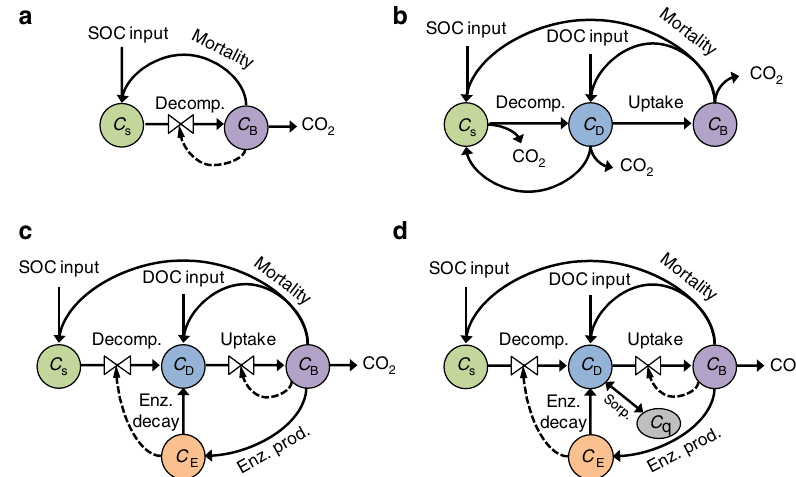
Fig. 1 SOC decomposition models compared in this study. a Two-pool microbial model with SOC ( C S ) and microbial biomass C (MBC; C B ) pools. b Three- pool linear, fi rst-order model with SOC, MBC, and dissolved organic C (DOC; C D ) pools. c Four-pool microbial model that includes enzymatic ( C E ) decomposition of SOC and subsequent assimilation (uptake) of DOC. d Five-pool microbial model that includes sorption of organic matter onto mineral surfaces to form mineral-associated organic C ( C q ) that is protected from enzymatic attack NATURE COMMUNICATIONS | 8: 1223 | DOI: 10.1038/s41467-017-01116-z |